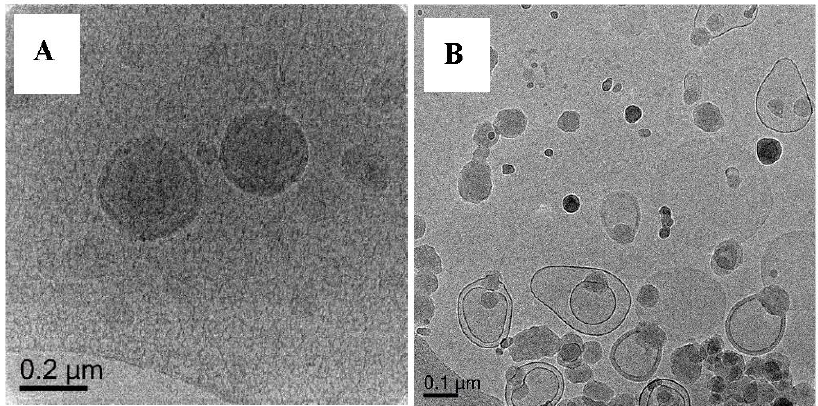
Figure 11. Cryo-TEM micrographs of Exp 6 ( A ), polymerization of (DODAB- Oligo1 ) with MA and Exp 7 ( B ), polymerization of (DODAB- Oligo1 ) with MMA. Additional images in Figure S5 (Exp 6) and Figure S6 (Exp 7).